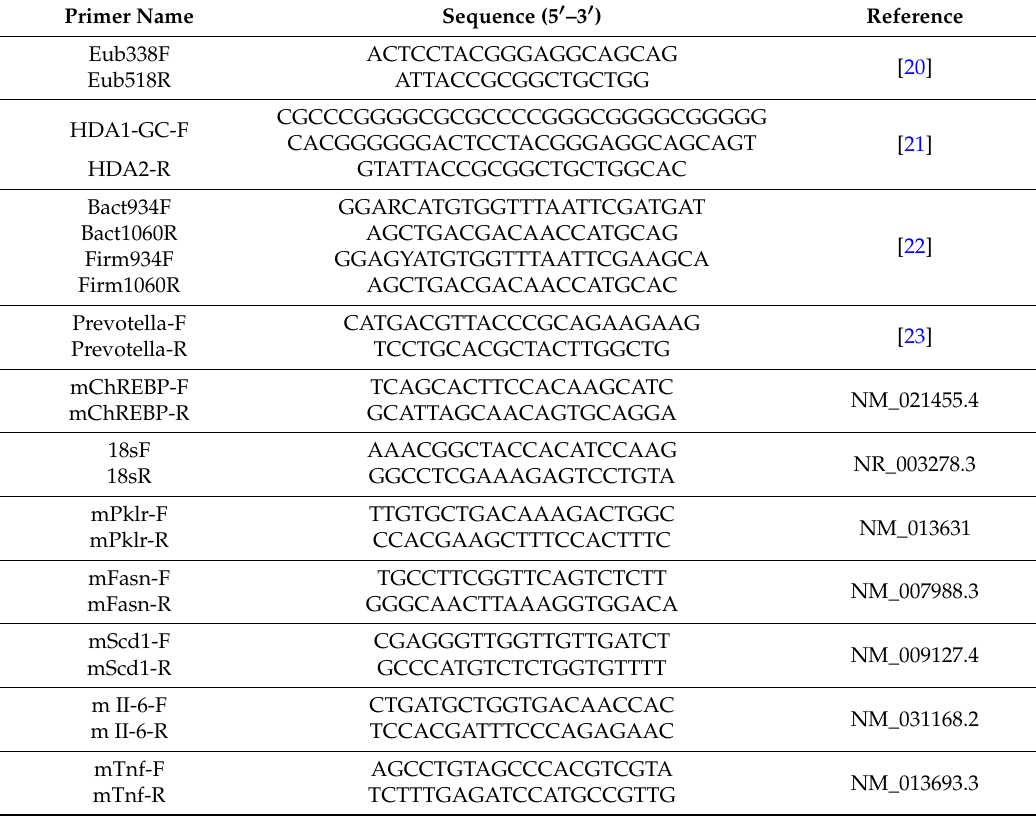
Table 1. Oligonucleotide